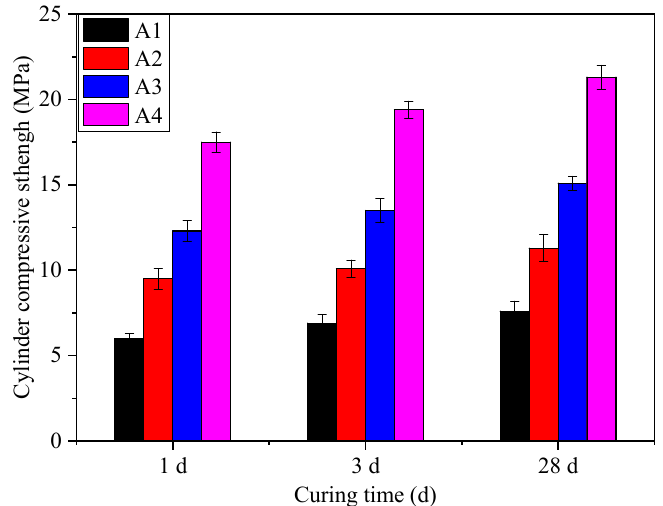
Figure 9. The influence of curing ages on cylinder compressive strength.